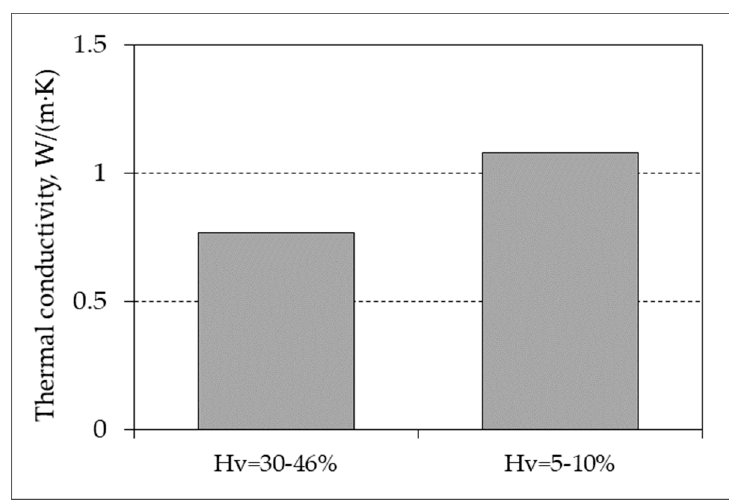
Figure 8. Thermal conductivity at different hydrate contents.